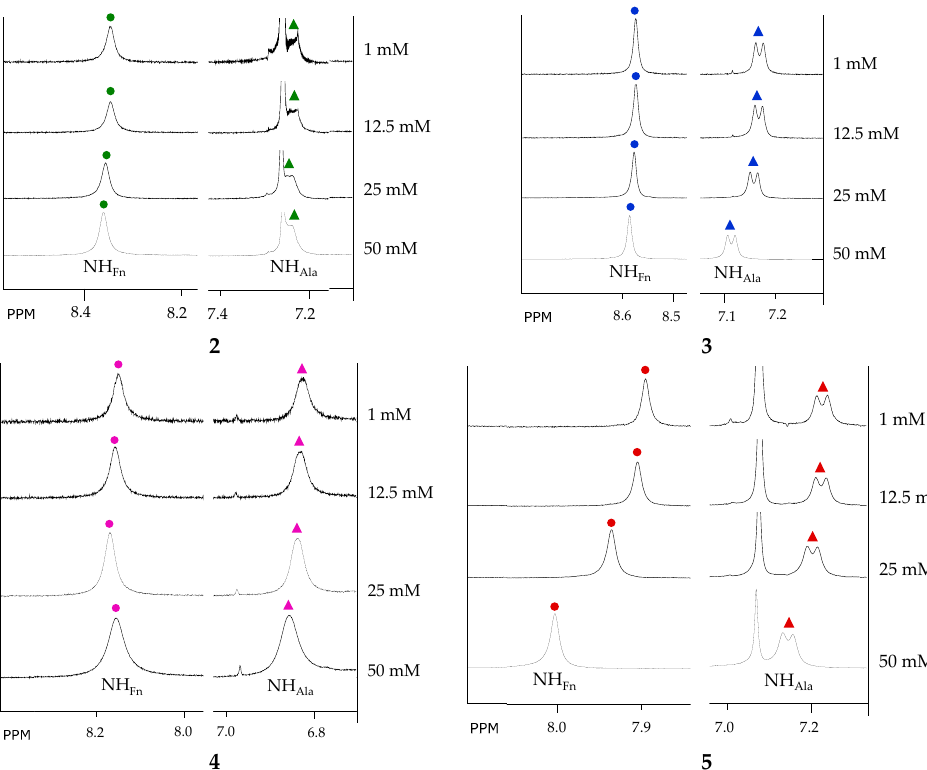
Figure 7. Concentration-dependent NH chemical shifts of hetero-( 2 , 3 ) and homochiral peptides ( 4 , 5 ).